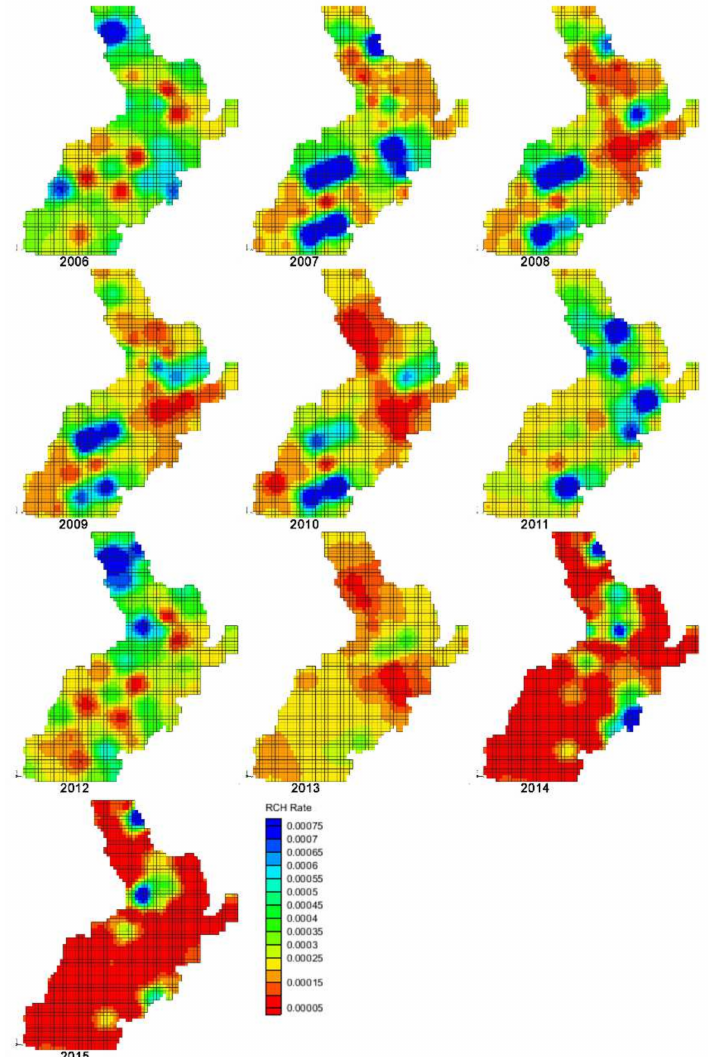
Figure 14. Spatial distribution of recharge after model